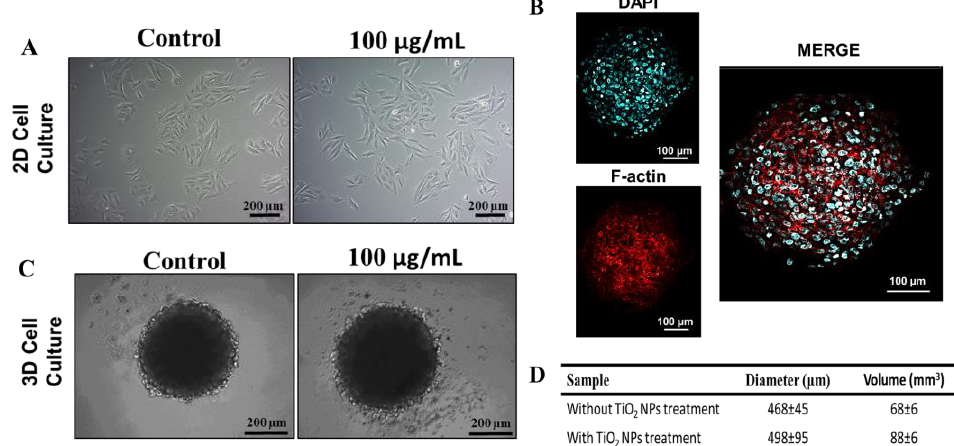
Figure 2. Treatment of TiO 2 NPs in 2D and 3D cultures of human osteoblasts (SAOS-2): ( A ) Phase contrast micrograph of SAOS-2 in 2D with or without 100 µg/mL of exposition to TiO 2 NPs for 72 h (scale bar: 200 µm) ( B ) Spheroid cytoskeleton (3D), nucleus in blue (stained with DAPI) and the actin filaments in red (stained for F-actin) (scale bar: 100 µm). ( C ) Phase contrast micrograph of SAOS-2 in 3D with or without 100 µg/mL of exposition to TiO 2 NPs for 72 h (scale bar: 200 µm). ( D ) Average diameter and volume of spheroids. The baseline condition was used as a control. The results are representative images of three independent